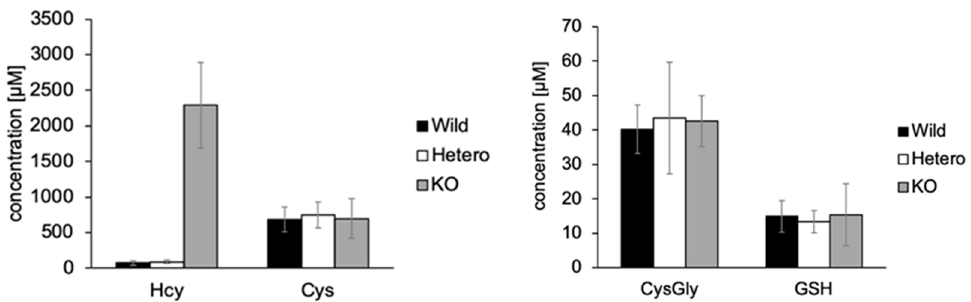
Figure 6. Concentration of thiols in CBS-WT, -Hetero, and -KO mouse urine samples. Numbers of samples—WT, n = 4; Hetero, n = 9; KO, n = 7. Error bars—standard deviation.